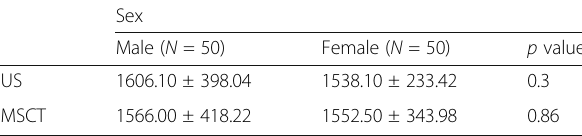
Table 3 Average liver volume by US and CT volumetry as regards